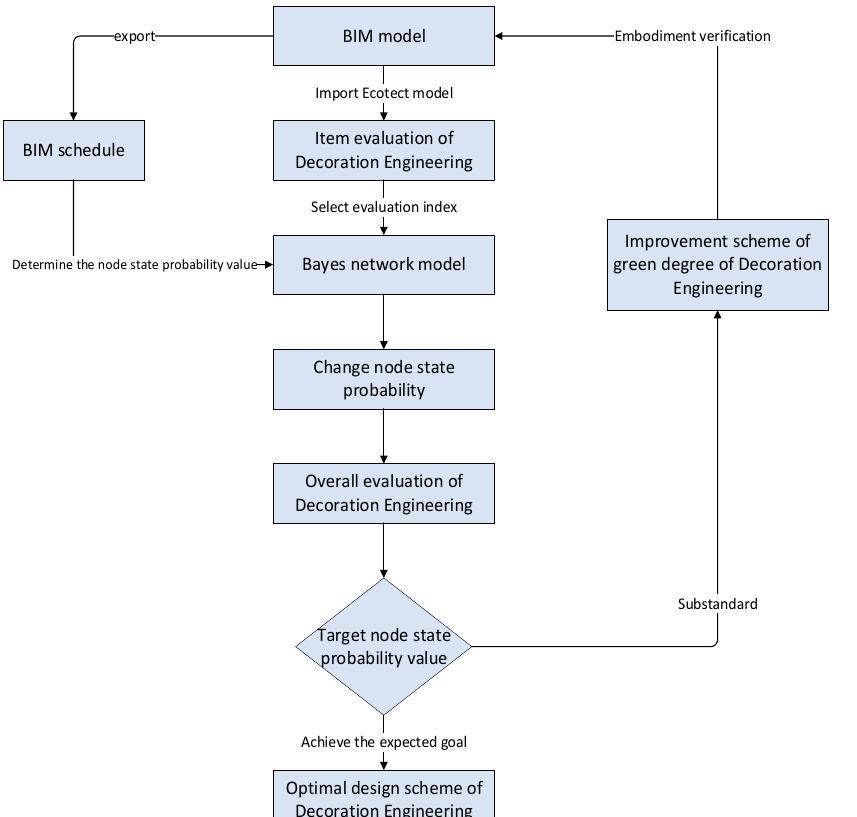
Figure 4. The evaluation process of building interior decoration is based on BIM-BN Technology.